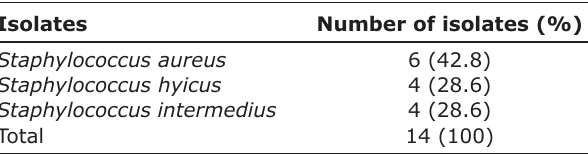
Table-3: Frequency of bacteria strains isolated from grown CMT-positive milk.